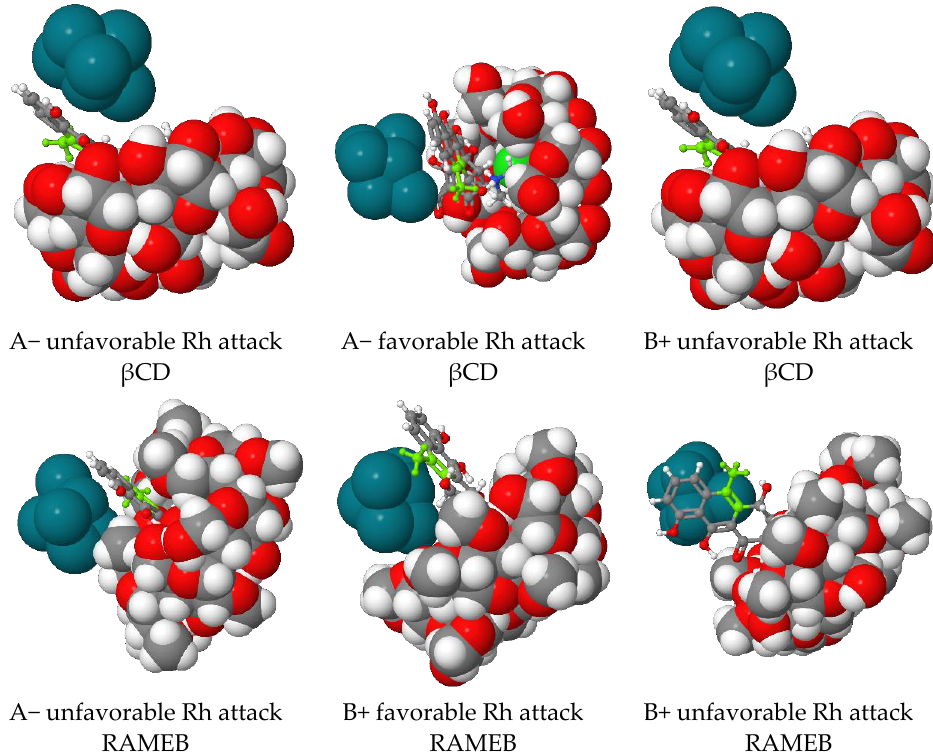
Figure 2. Possible attachment of the Rh nanoparticles around C-6 (figures shows the optimized in- termediate/CD complexes (PM6 method) with the molecular mechanics (MMFF94) optimized Rh